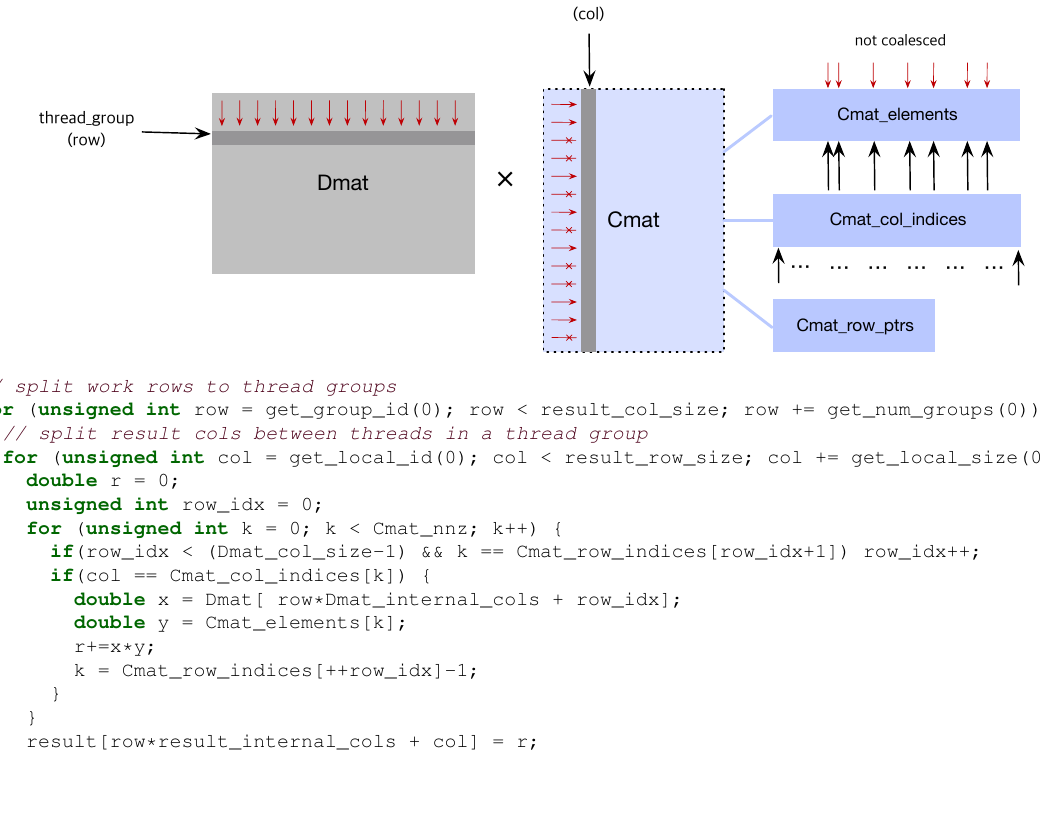
Figure 3. OpenCL kernel for the Dense( Dmat ) × Compressed( Cmat ) operation.